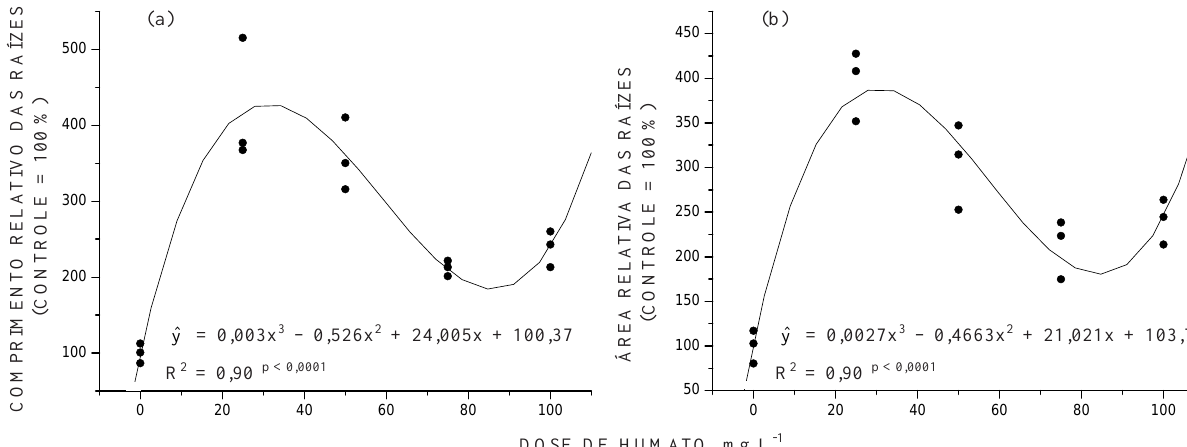
Figura 1. Incremento do comprimento (a) e da área radicular (b) da alface em relação ao